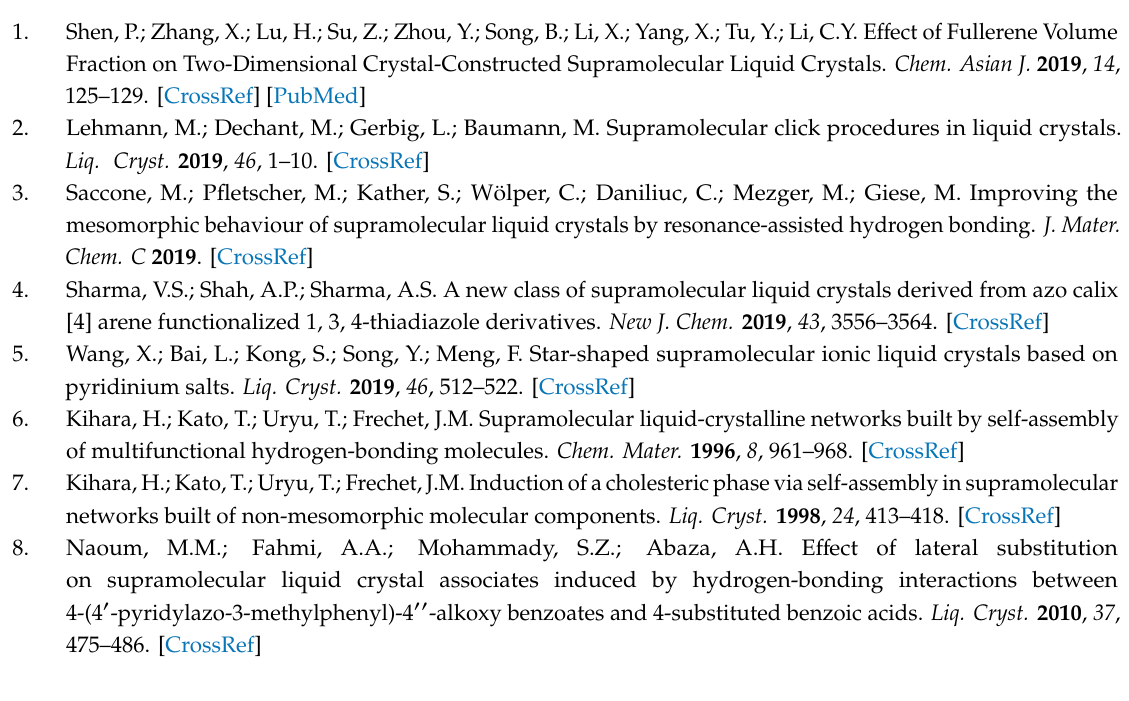
Supplementary Materials: The following are available online, Figure S1. DSC thermograms of A 12 / I 16 supramolecular complex upon heating and cooling cycles with heating rate 10 ◦ C / min. Figure S2. DSC thermograms of A 12 / II 16 supramolecular complex upon heating and cooling cycles with heating rate 10 ◦ C / min. Figure S3: Some textures (Size: 41.8 × 10 6 nm) under POM of the supramolecular complexes upon heating (1) solid phase of A 10 / I 8 at 52.0 ◦ C; (2) nematic phase of A 6 / I 8 at 75.0 ◦ C; (3) nematic phase of A 6 / II 8 at 112.0 ◦ C; and (4) nematic phase of A 8 / II 8 at 85.0 ◦ C. Table S1: Normalized entropy change ( ∆ S / R) for the supramolecular complexes A n / III 16 and A n / IV 16